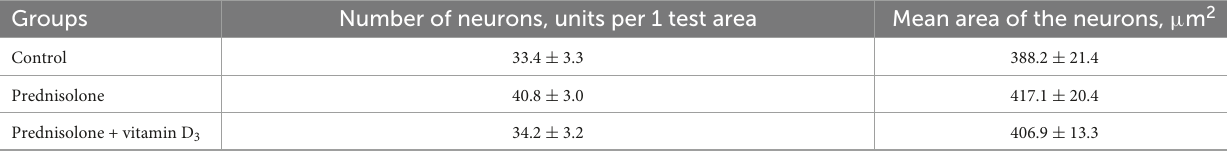
TABLE 5 Morphometric parameters of the ganglionic layer of the cerebellum (test area – width of the cortex layer 500 µ m, M ± m, n = 5).